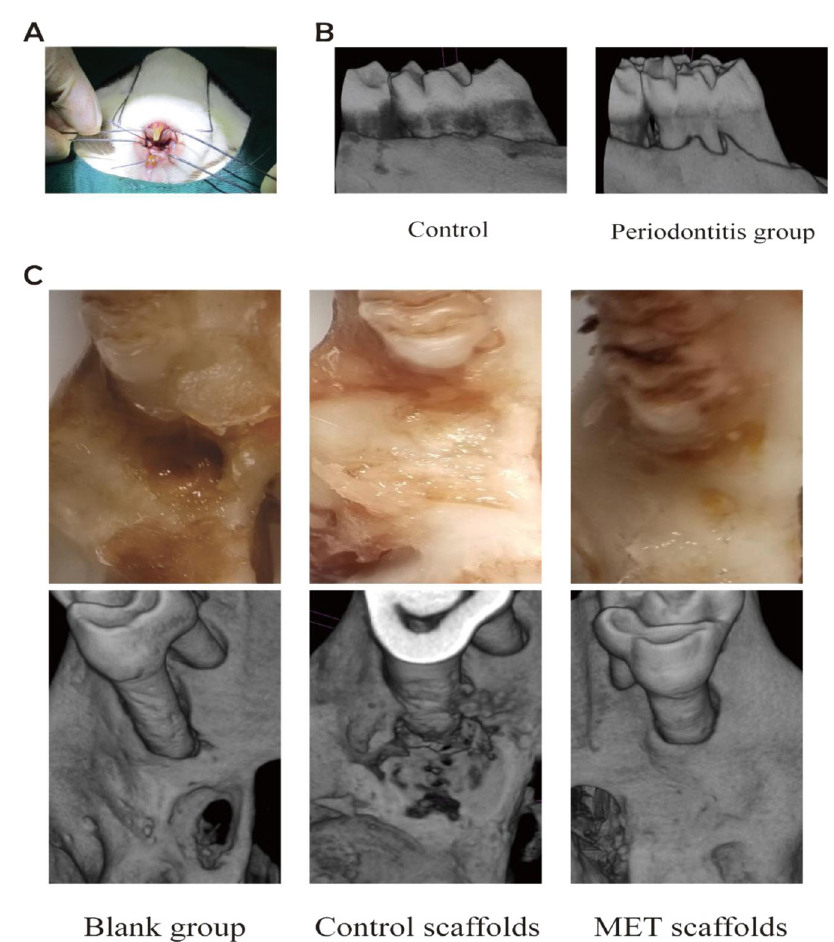
Fig. 6 A The operation of the periodontal model. B Scan the periodontal tissues around the molars of the periodontitis group and normal healthy rats with Micro-CT. C Repair of